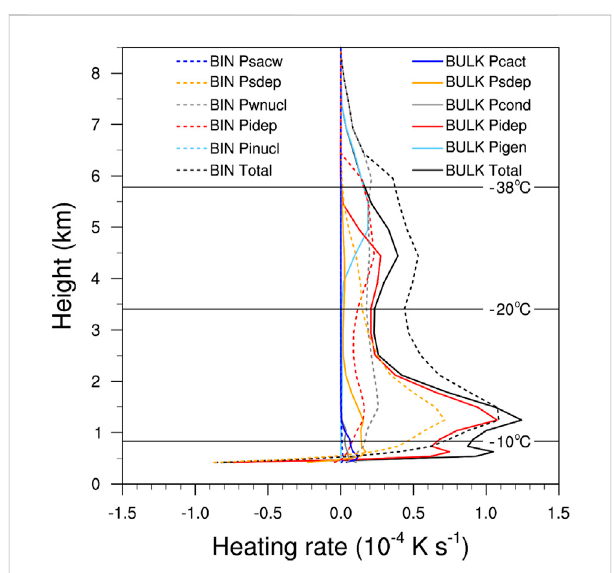
Average pro fi les of latent heating and cooling rates (unit: 10 – 4 K s − 1 ) for various microphysical processes from 2000 UTC on February 12 to 1600 UTC on February 13, 2022, for the BULK and BIN